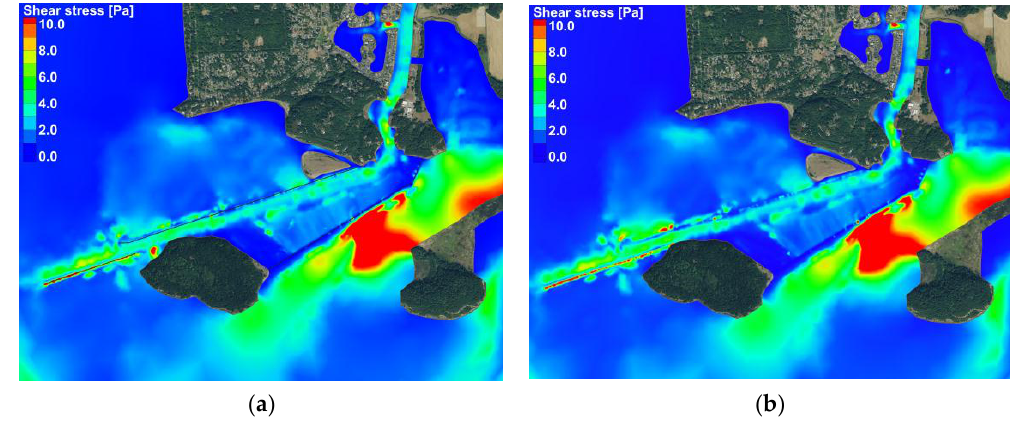
Figure 11. Time averaged bottom shear stress distribution (20 days) for ( a ) baseline conditions and ( b ) Jetty Repair Scenario, SCN-1.